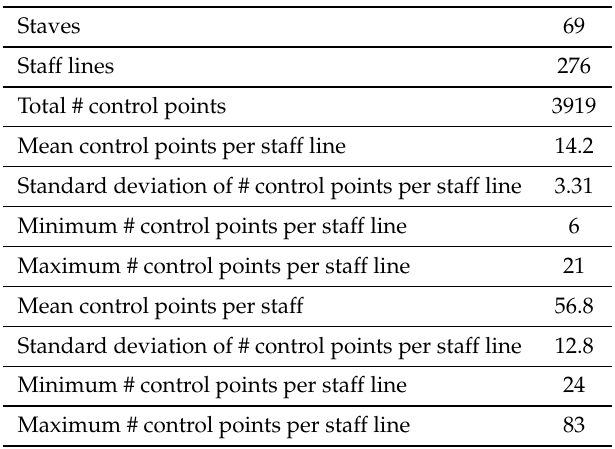
Table 1. Summary of the ground truth data creation parameters.